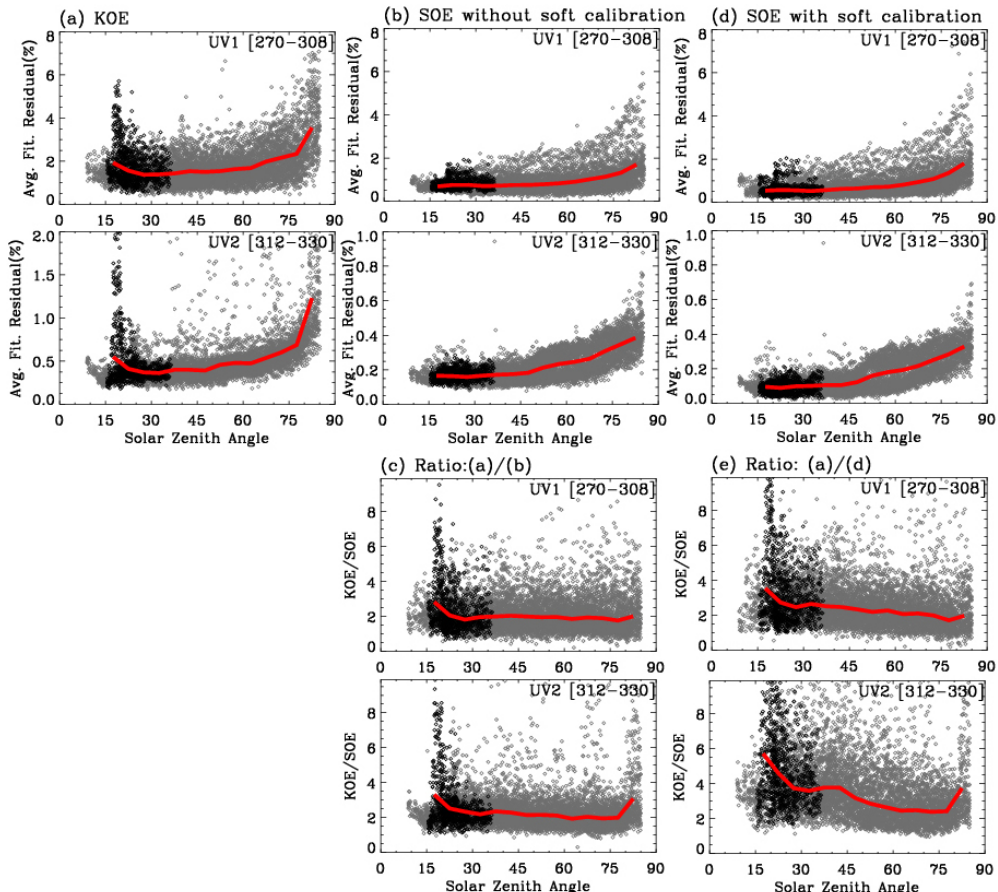
Figure 9. Average fitting residuals in UV-1 and UV-2 channels for an orbit of retrievals (orbit 09987) on 1 June 2006 using (a) KOE, (b) SOE without soft calibration, and (d) SOE with soft calibration, as a function of solar zenith angle, with (c, e) the ratios of KOE to SOE fitting results. The average fitting residuals are defined as wavelengths are 270, 272.5, 274.7, 280.1, 282.5, 285.1, 287.0, 288.1, 290, 295, 300, 305, 308nm in UV-1 channel and 312, 313, 315, 317.5, 320, 322.5, 325, 327.5, 330nm in UV-2 channel, corresponding to outputs of KOE. The sun-glint-contaminated pixels are indicated by the black symbol. The red line indicates the average in 5 ◦ SZA